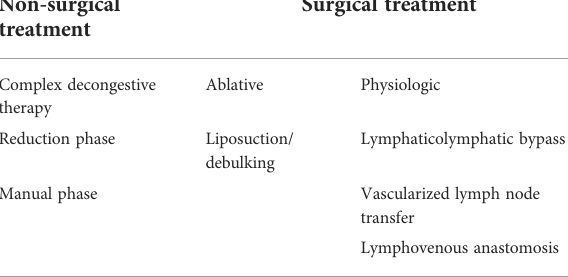
TABLE 4 Treatment of